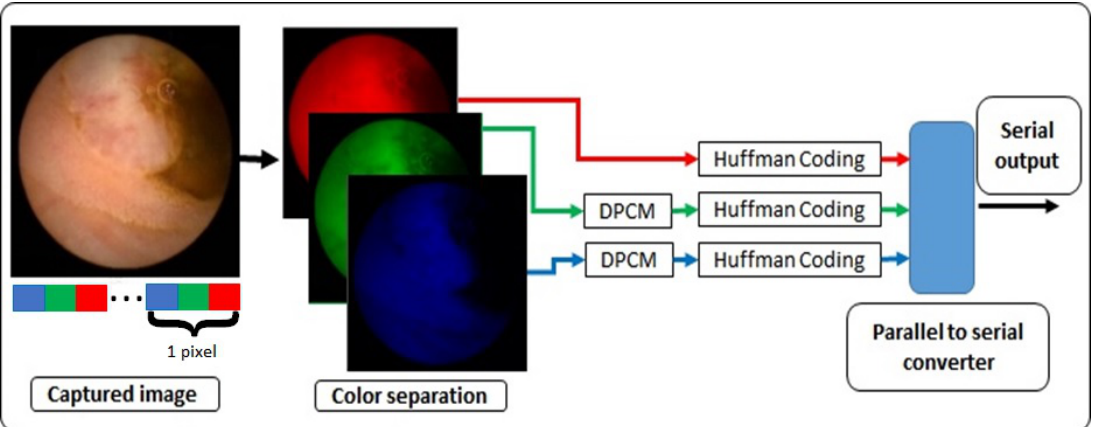
Figure 2. Image compressor structure.